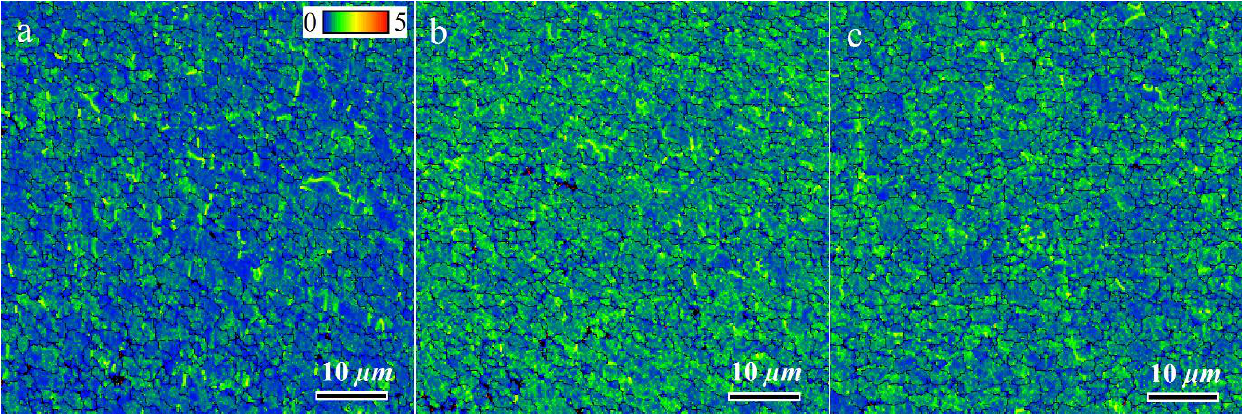
Figure 17. Kernel average misorientation (KAM) maps of SZs in different samples: ( a ) S1, ( b ) S2, and ( c ) S3.